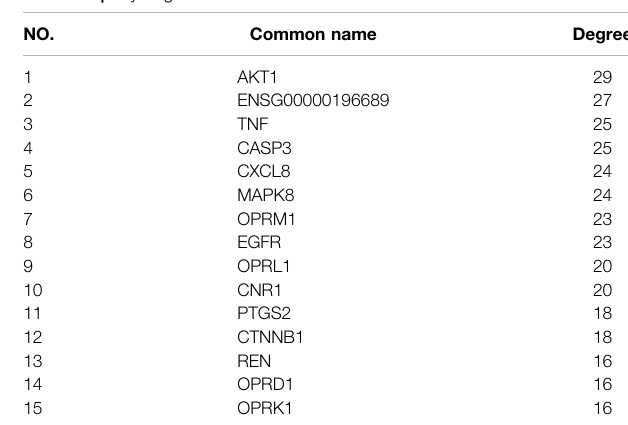
TABLE 2 | Key targets of the PPI